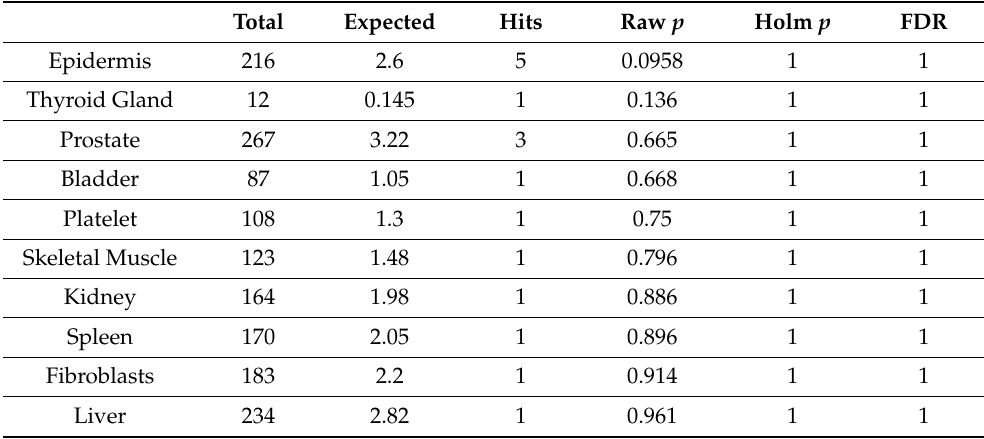
Table 4. Over-representation analysis of compounds in different organs.